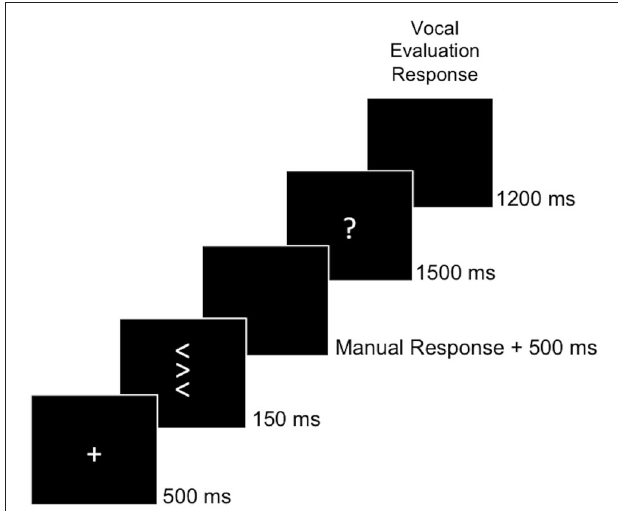
FIGURE 2 | Behavioral Task . The task was to classify the central target arrow with respect to its direction by a manual response. After the manual response, a question mark prompted participants to evaluate their own behavior by saying “giusto” (engl. correct) if they thought having responded correctly or “sbagliato” (engl. wrong) if they thought having responded erroneously.